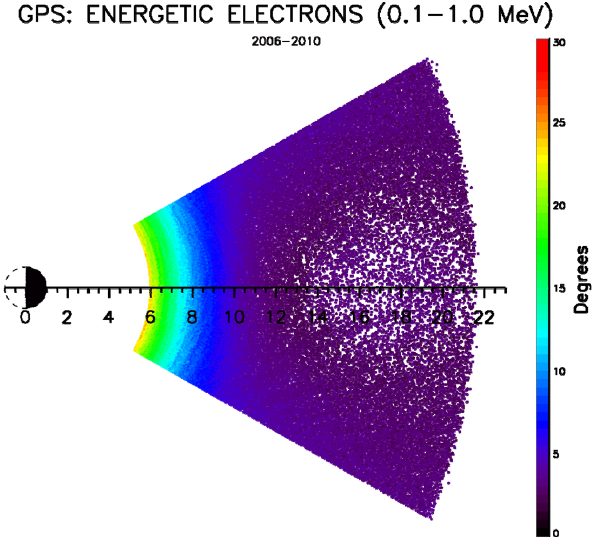
Fig. 1. Scatter plots of the pitch angle of the electrons derived from measurements by GPS spacecraft at high-latitude and then mapped to the equatorial plane using the Tsyganenko T89 model as a func- tion of LT and L. Substantial overlap of the 151574 data points occurs in the region closest to